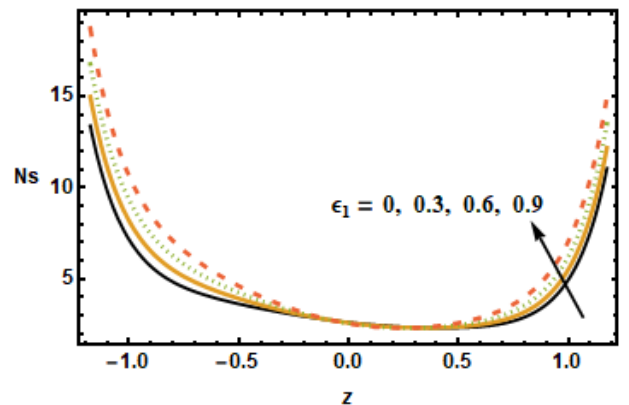
Figure 23. Effects of rotation parameter T (cid:48) on Ns .